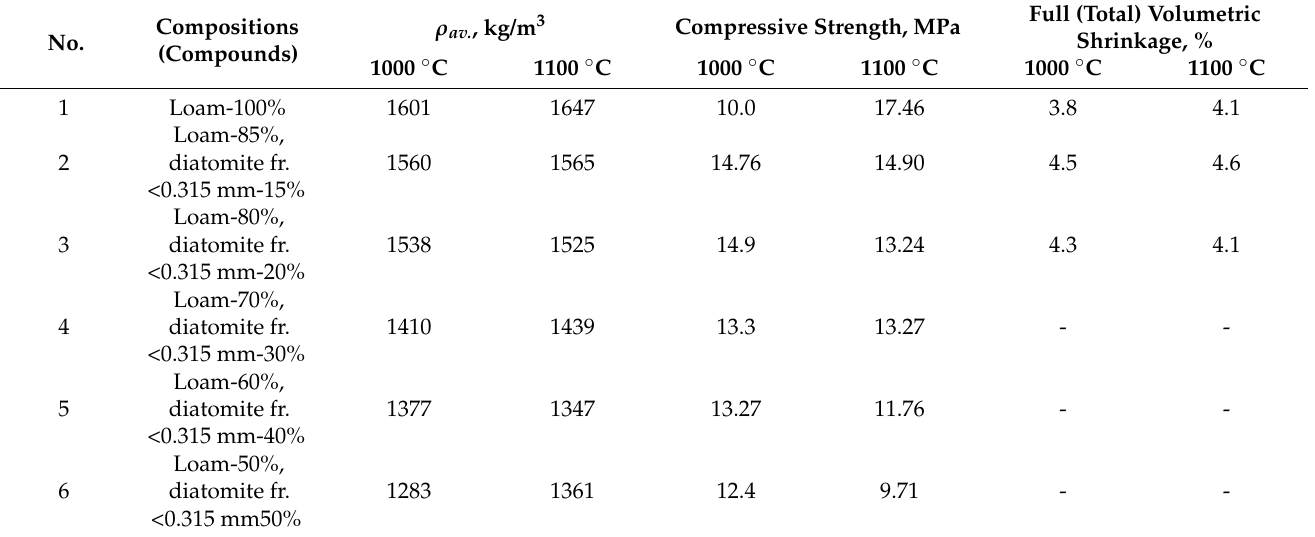
Table 1. The compounds and properties of samples of ceramic materials with diatomite from the Zhalpak deposit.